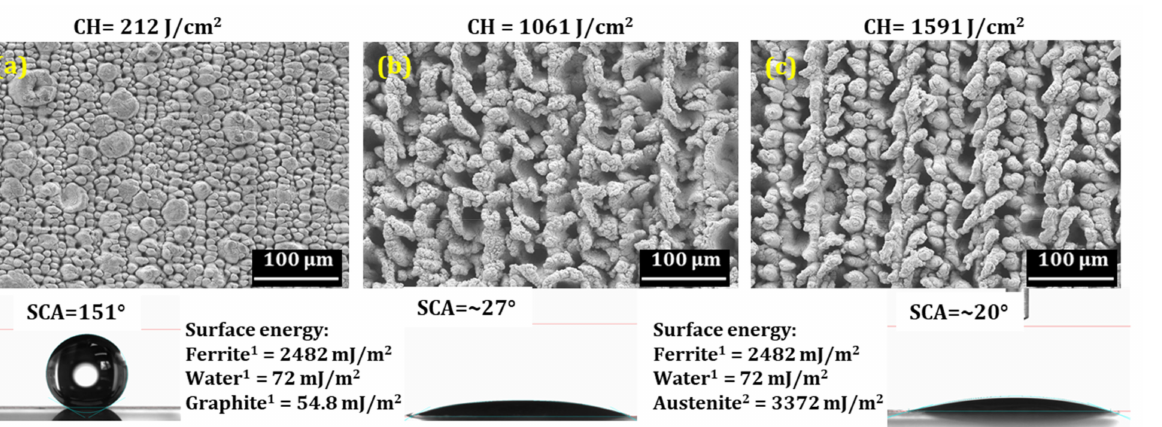
elemental concentration; Figure S2: Texture intensity of the samples taken deeper from the laser structured surface (Area of interest marked in green); Figure S3: 3D-surface topography and the corresponding Sa values at 212 J/cm 2 and 1591 J/cm 2